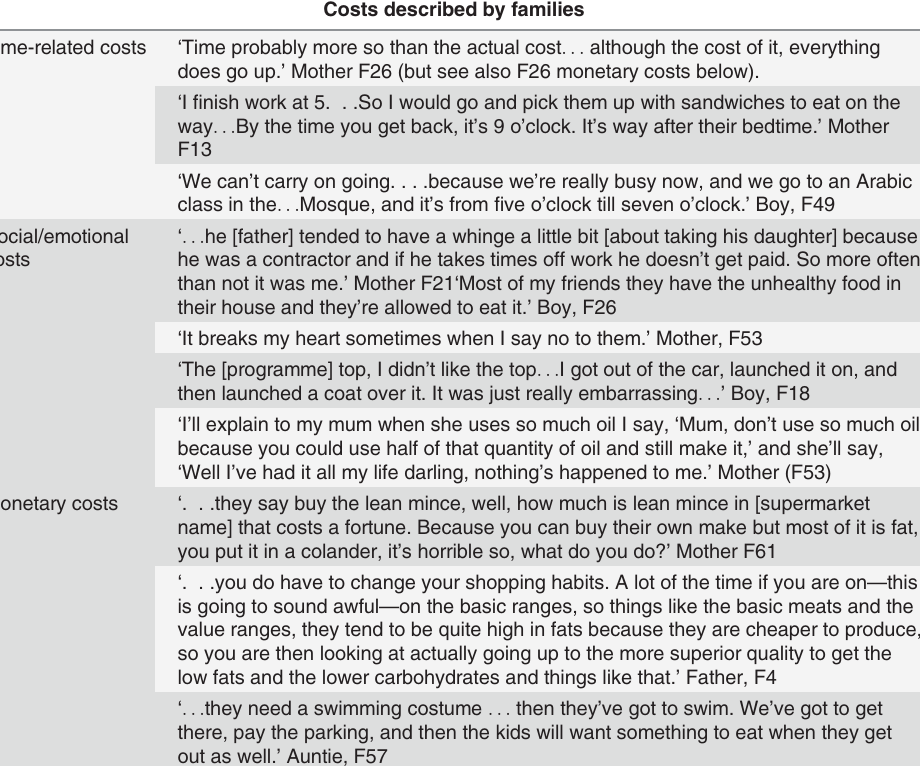
Table 3. Costs described by